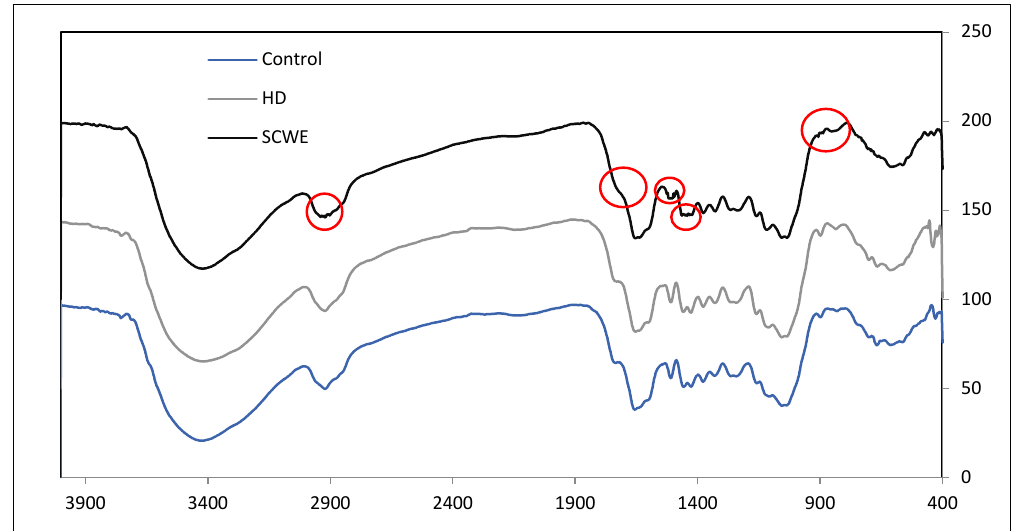
Figure 6. FTIR result for A. malaccensis wood before and after extraction by HD and SCWE. FTIR spectrum of A. malaccensis wood after SCWE was observed to be slightly different, from the control and HD spectrum. The intensity of the absorbance bands for cellulose and hemicellulose [43,50] either decreased a little, or vanished entirely in the SCWE spectrum’s points of 885 cm −1 (C-H bend aromatic/deformation vibration), 897 cm −1 (C-O-C stretching), 1030 cm −1 , 1170 cm −1 (C-O stretch vibration), 1375 cm −1 , 1480 cm −1 (C-H bend), 1420 cm −1 (CH 3 bend), 1710 cm −1 (C=O stretch vibration), and 2910 cm −1 (C-H stretch). FTIR absorption peak of 897 cm −1 generally corresponds to β (1 → 4)- glycosidic linkages [53]. The absence of this peak (897 cm −1 ) upon treatment of SCWE (at 225 °C) is believed to be due to the breaking of β (1 → 4)- glycosidic bonds (cellulose to glucose) [53]. This glucose is then further decomposed into furfural as can be detected by GC/MS results presented previously. Previous workers have demonstrated the use of temperature as high as 250 °C in order to observe significant changes in FTIR of the cellulose sample [53]. The slight difference between the spectrums of the sample after SCWE and the control sample provides some evidence of SCWE’s ability to break down the chemical structures of cellulose and hemicellulose in the wood matrices of A. malaccensis . Although the changes in FTIR of the sample from SCWE in this work is not apparent, previous studies have demonstrated the effective influence of the SCWE condition on the hydrolysis of the sample’s cellulose and hemicellulose to glucose [39,53]. In short, the FTIR analysis showed some changes and partially supports other findings (yield and SEM) from this work. 3.2.4. Brunauer-Emmett-Teller (BET) Surface Area Analysis and Barrett-Joyner-Halenda (BJH) Pore Size and Volume Analysis The effectiveness of extraction methods on the wood of A . malaccensis was assessed through BET surface area and BJH pore size. These tests measure the surface area of the sample, as well as its pore size, by referring to the amount of the N 2 gas they absorb. As shown in Figure 7, the pore size graph of the untreated sample (raw wood sample) is slightly different from that of the wood after extraction by HD and SCWE, in both range and distribution of pore sizes. The pore sizes in the raw wood sample in the range of 300 – 450 Å vanished following the HD extraction. The pore size of both HD (soaking and extraction) and SCWE changed to 400 – 950 Å, implying that the rupturing of small pores rendered them larger. The similarity of the effect of HD and SCWE on the porosity of the wood sample indicates that SCWE (similar to HD) can effectively extract essential oil, even if the extraction time is brief. However, despite the fact that the range of pore size is similar in both samples after HD and SCWE, the BET result showed that the pore volume of the wood sample significantly increased from 0.063353 cm 3 /g (i.e.,